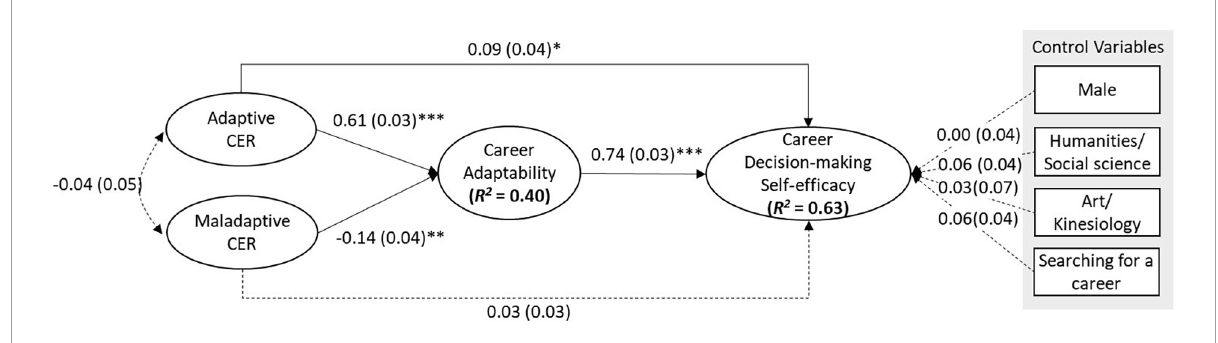
FIGURE2 Path analysis results with the standardized path coefficients. ∗∗ p < 0.01, ∗∗∗ p < 0.001; a number in the parenthesis indicate the corresponding standard error for each of the standardized path coefficients; we provided unstandardized path coefficients for control variables since they were either binary or dummy-coded variable; a dotted line indicates a non-significant path.